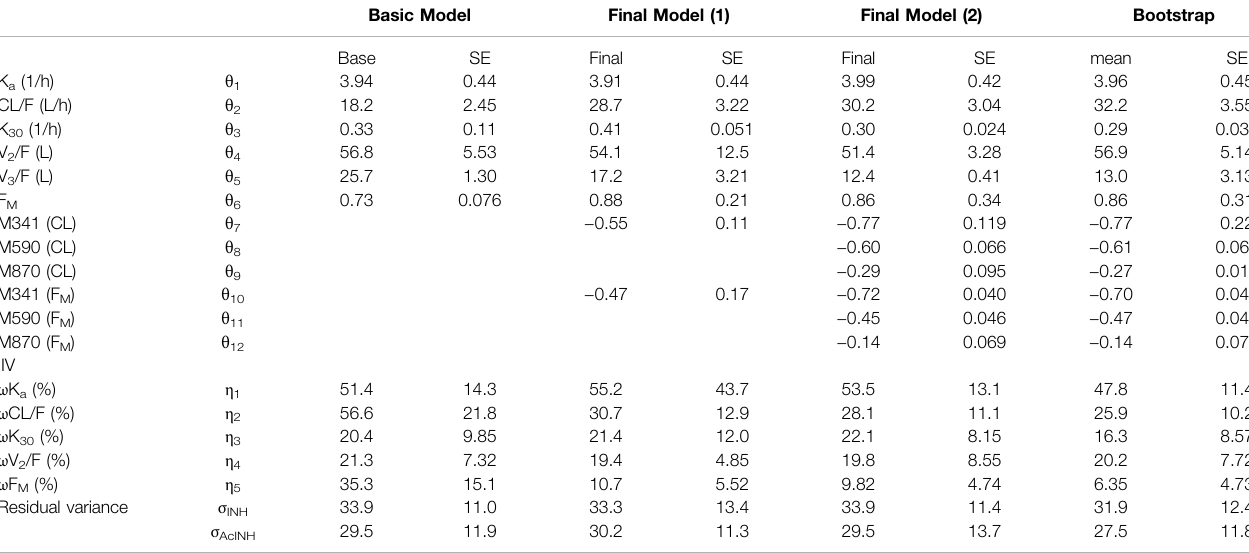
TABLE 3 | Parameters of integrated PPK model of INH and AcINH in Chinese healthy subjects and tuberculosis patients.